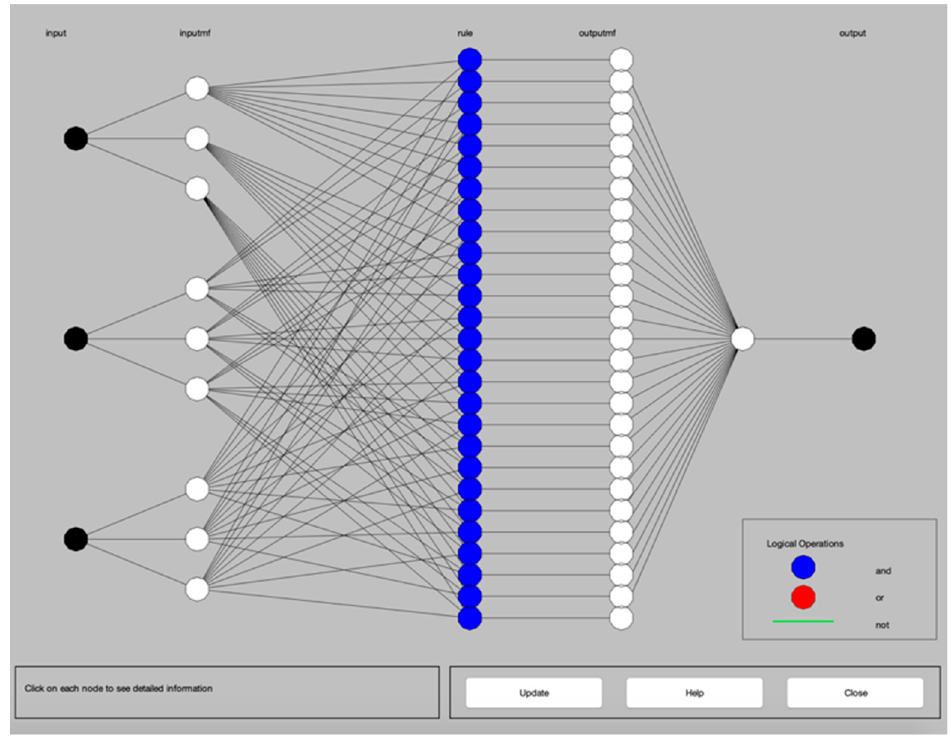
Figure 3. ANFIS structure.